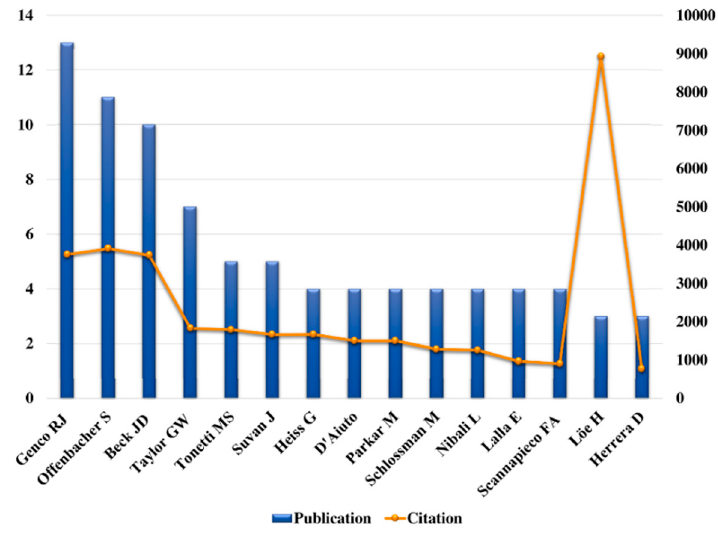
Figure 3. Citation analysis of the authors who contributed to the top 100 most-cited articles.